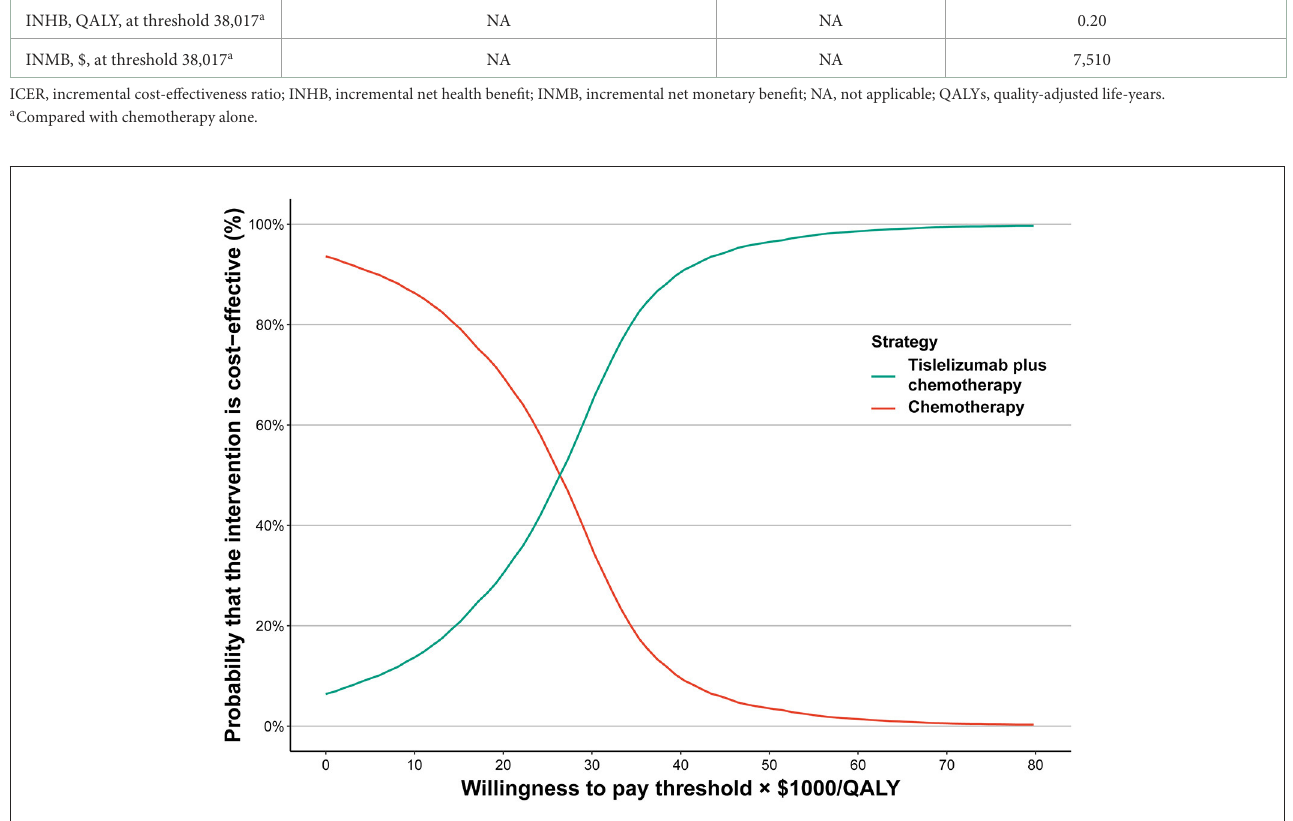
chemotherapy being considered cost-effective was